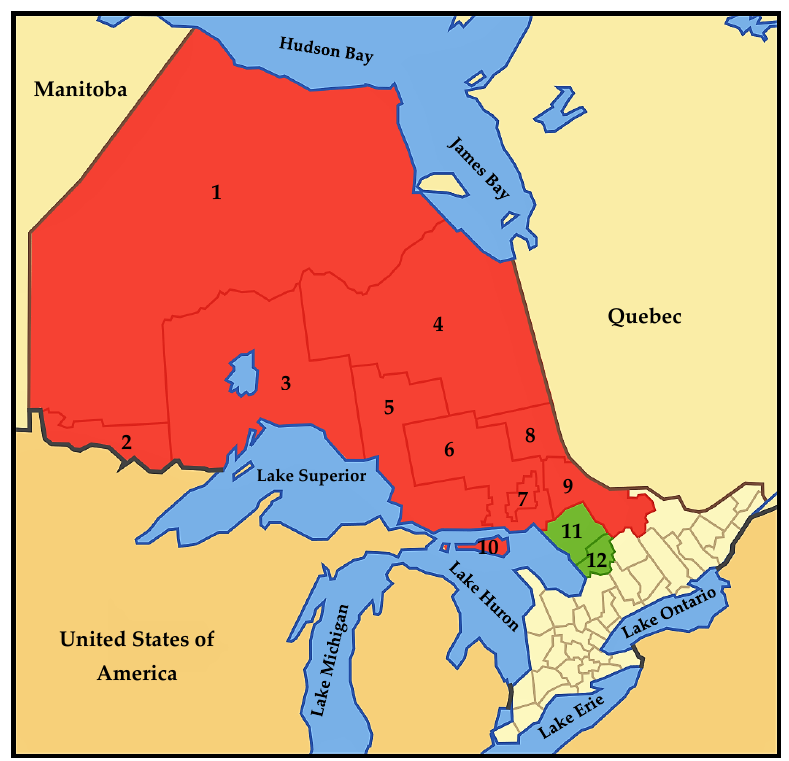
Figure 1. District/regions in Northern Ontario. Legends: 1. Kenora, 2. Rainy River, 3. Thunder Bay, 4. Cochrane, 5. Algoma, 6. Sudbury, 7. Greater Sudbury Division, 8. Temiskaming, 9. Nipissing, 10. Manitoulin, 11. Parry Sound, and 12. Muskoka. The red area represents the core area; green indicates the extended area (i.e., service area of FedNor); cream/white area represents Southern Ontario; and blue represents lake/water areas.